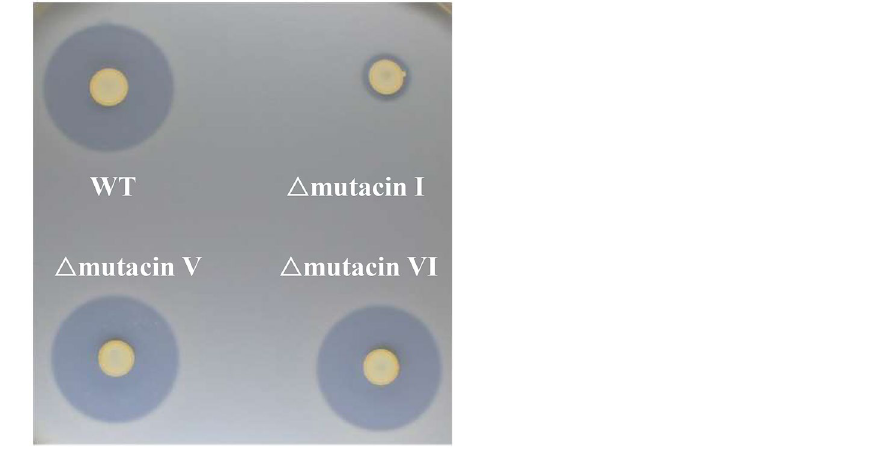
Figure 8. Antibacterial activity of mutacin I-, V- and VI-KO mutants. The antibacterial activity of the wild type (KSM157) and its mutants against S. salivarius was evaluated by the direct method described in the Materials and methods